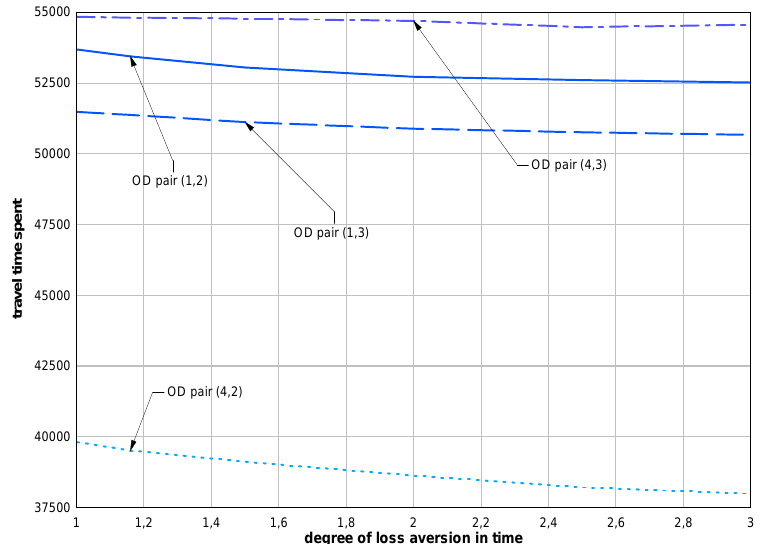
Figure 6. Variation of total travel time spent on the network with degree of loss aversion in the time attribute